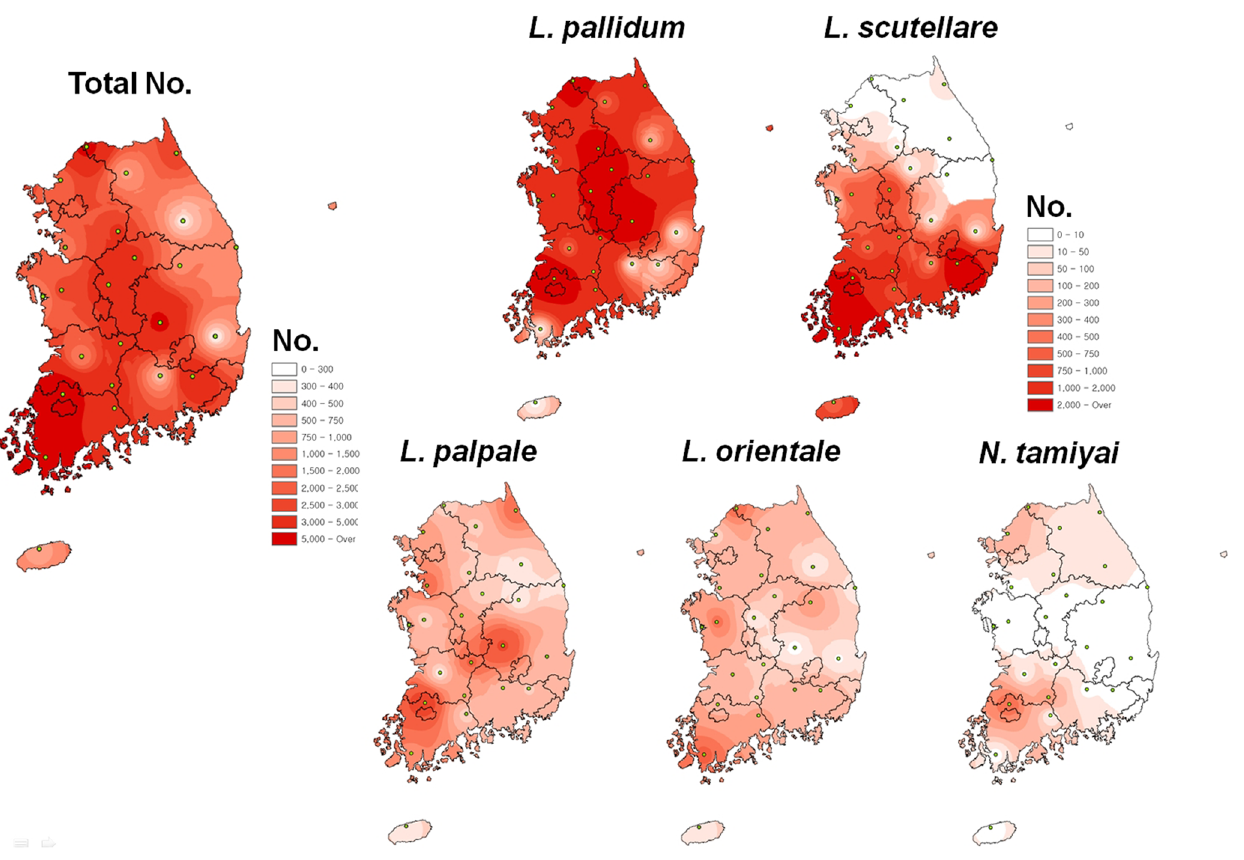
Fig. 4. Geographical distribution of chigger mites. The map color indices differ between the total number (0– over 5,000) and species maps (0– over 2,000).